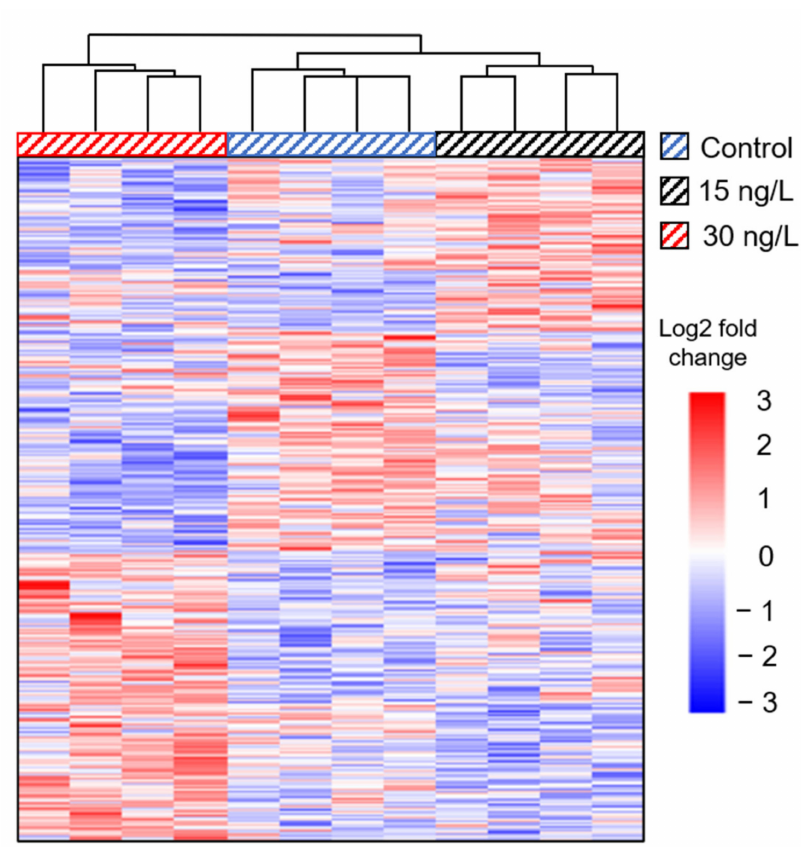
Figure 1. Heatmap dendrogram comparing differentially expressed genes (DEGs) in the brains of juvenile rainbow trout exposed to 0, 15, and 30 ng/L